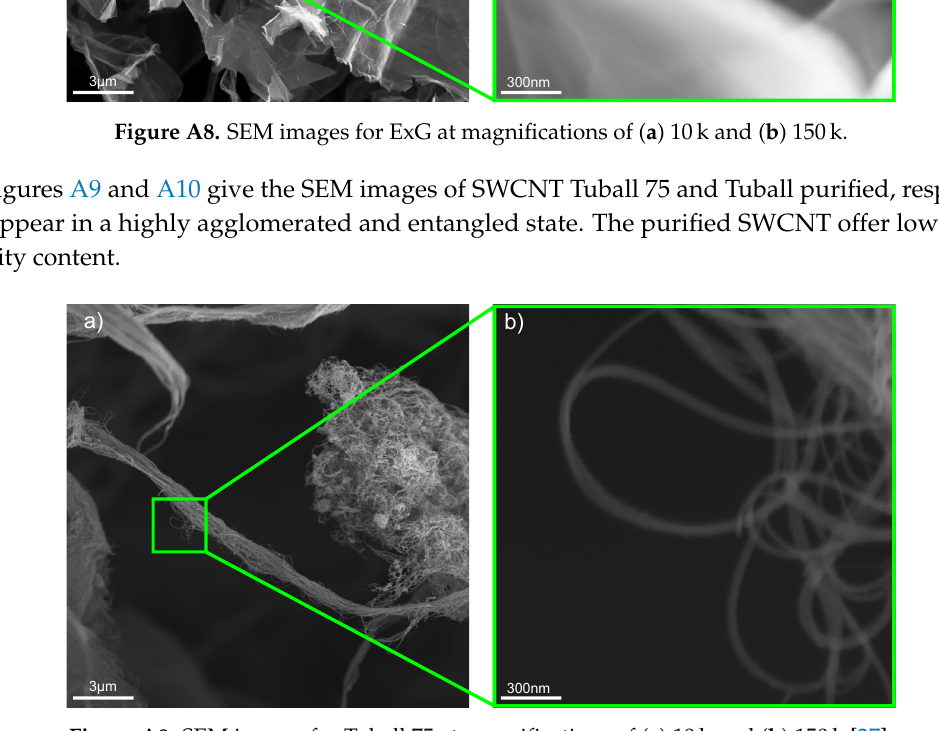
Figure A9. SEM images for Tuball 75 at magnifications of ( a ) 10k and ( b ) 150k